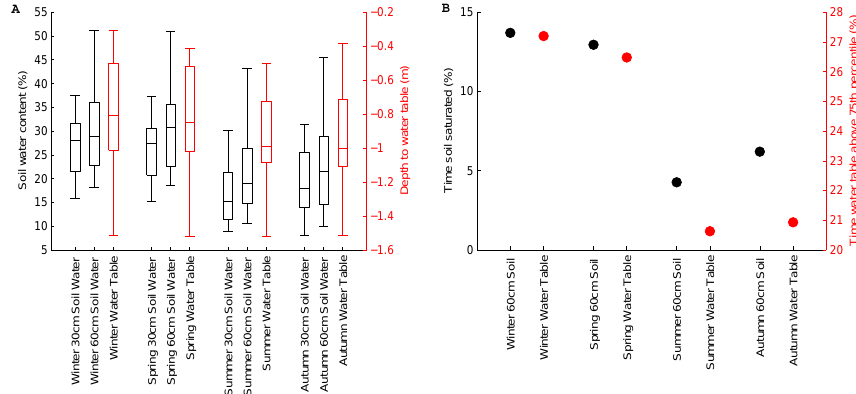
Figure 4. Summary statistics of soil moisture and depth to water table by season. (a) Distributions of measured values. (b) Summary of wet extremes.